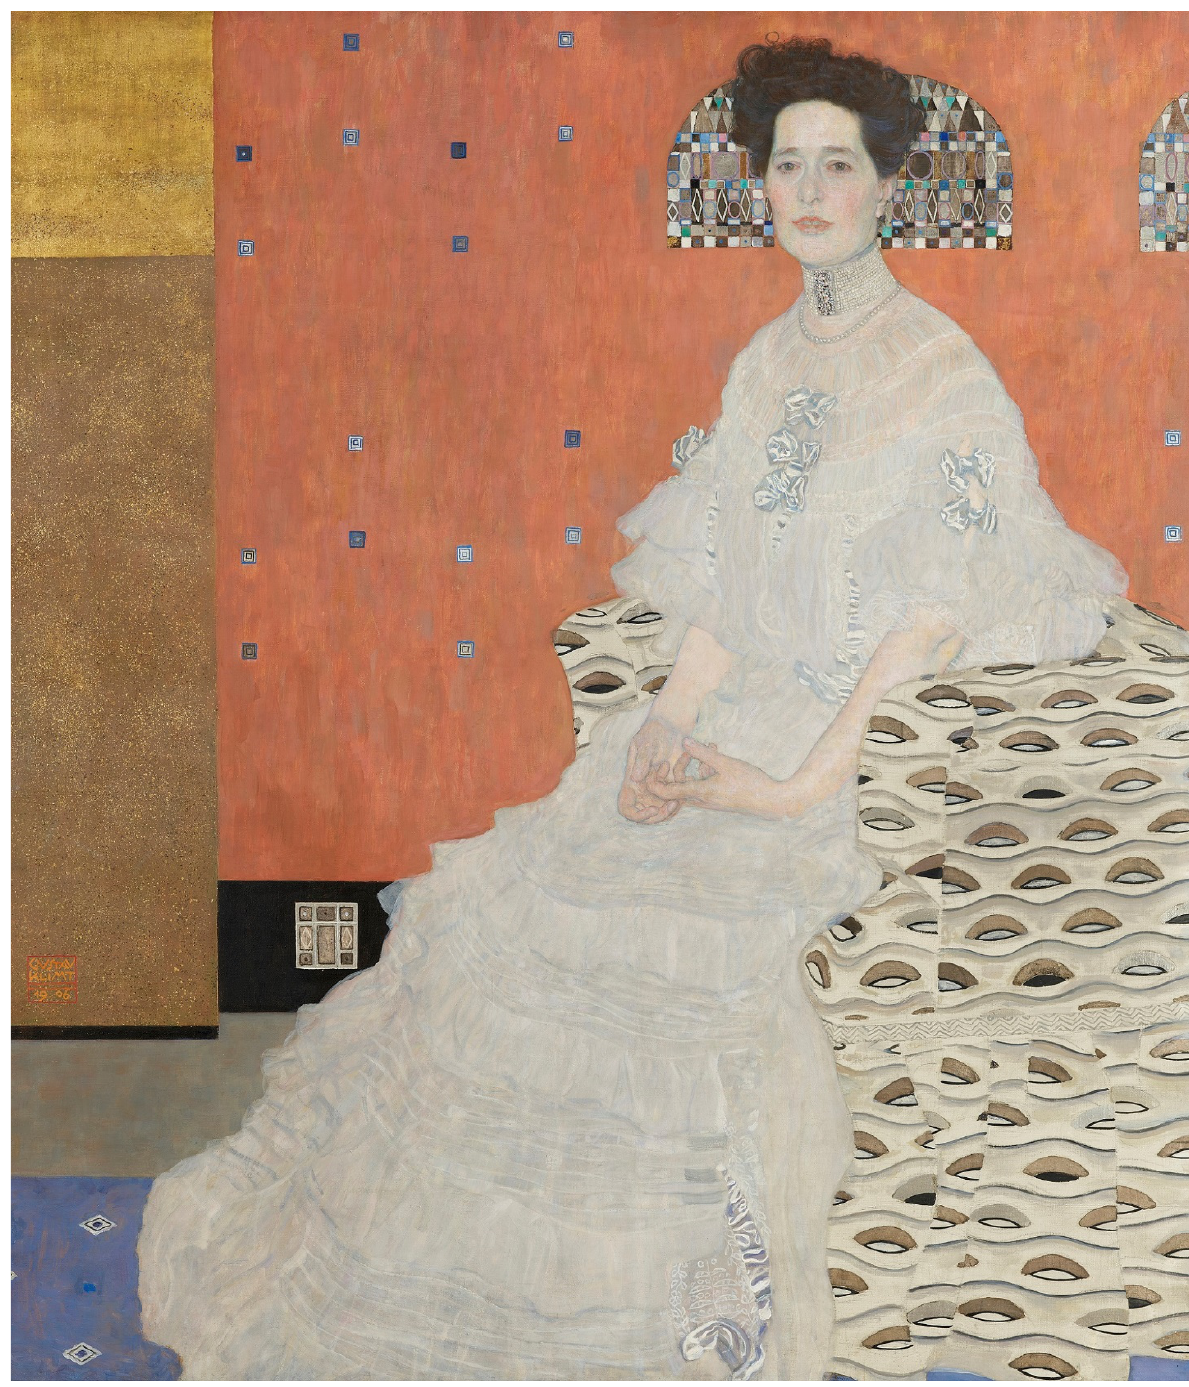
Figure 1: Gustav Klimt, Portrait of Fritza Riedler, 153 x 133 cm, 1906; Galerie Belvedere,